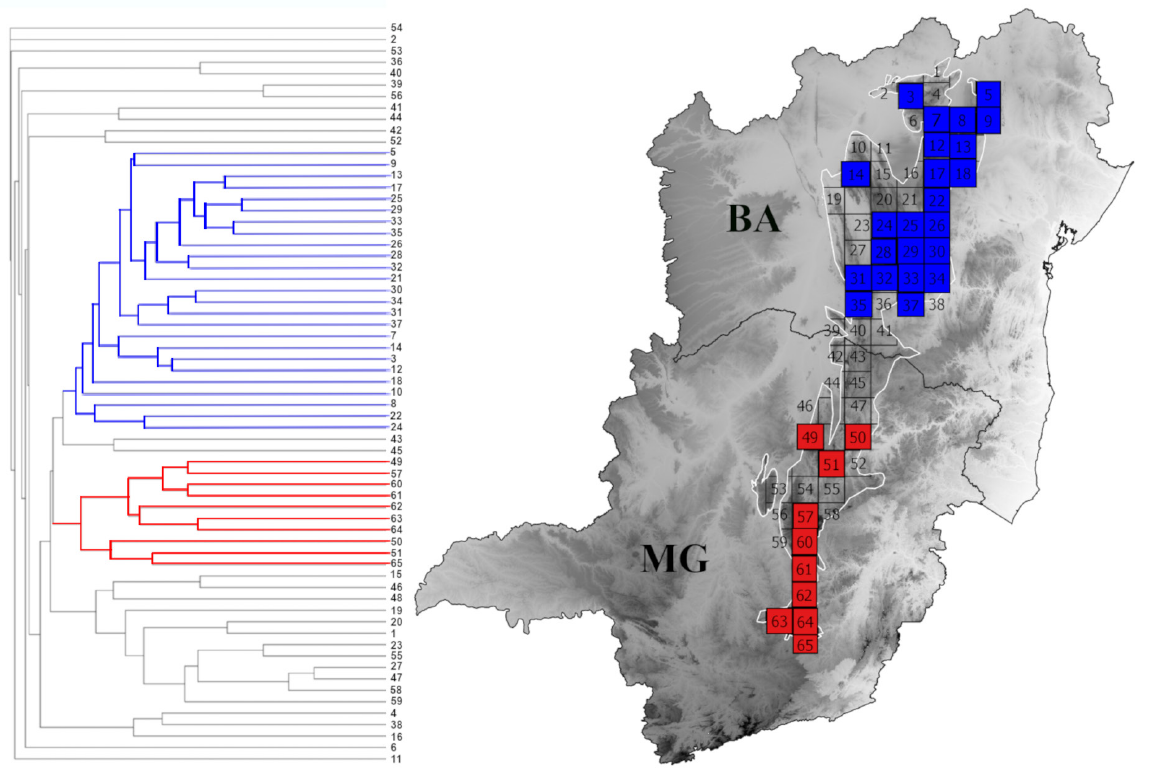
Figure 5. Floristic similarity of Convolvulaceae in the Espinhaço Range. The cluster analysis showed two main groups: one in the Bahia portion (blue squares) and another in the Minas region (red squares). This floristic similarity pattern is depending on the geographic location of the squares and apparently occurs to the detriment of climatic influences surrounding domains in the